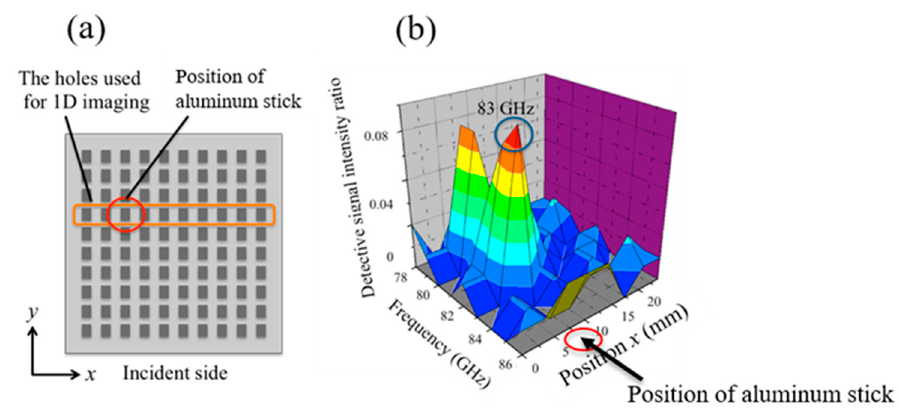
Figure 12. The conductive probe for localized electromagnetic distortion.